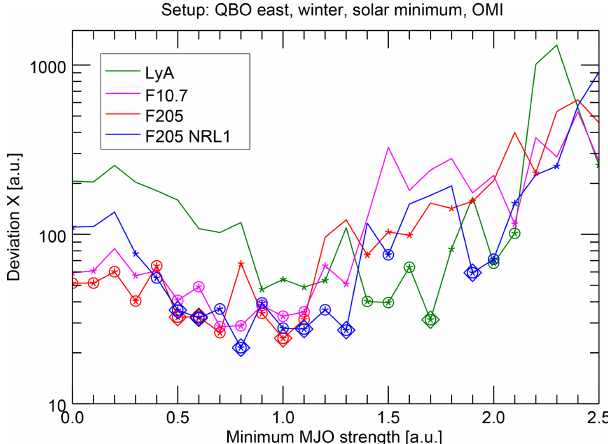
Figure 11. As in Fig. 5, but also showing the analysis results for alternative solar proxies. The green line corresponds directly to the green line in Fig. 5. Note that this figure is shown in logarithmic scaling for an easier inspection of the comparatively slight differ-